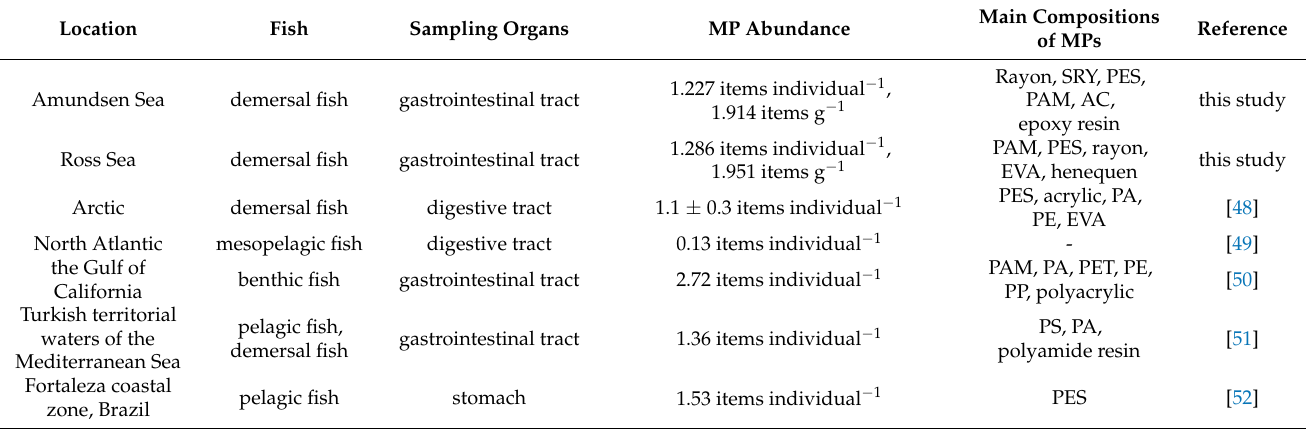
Table 3. Studies on MP abundances in fish species from different waters around the